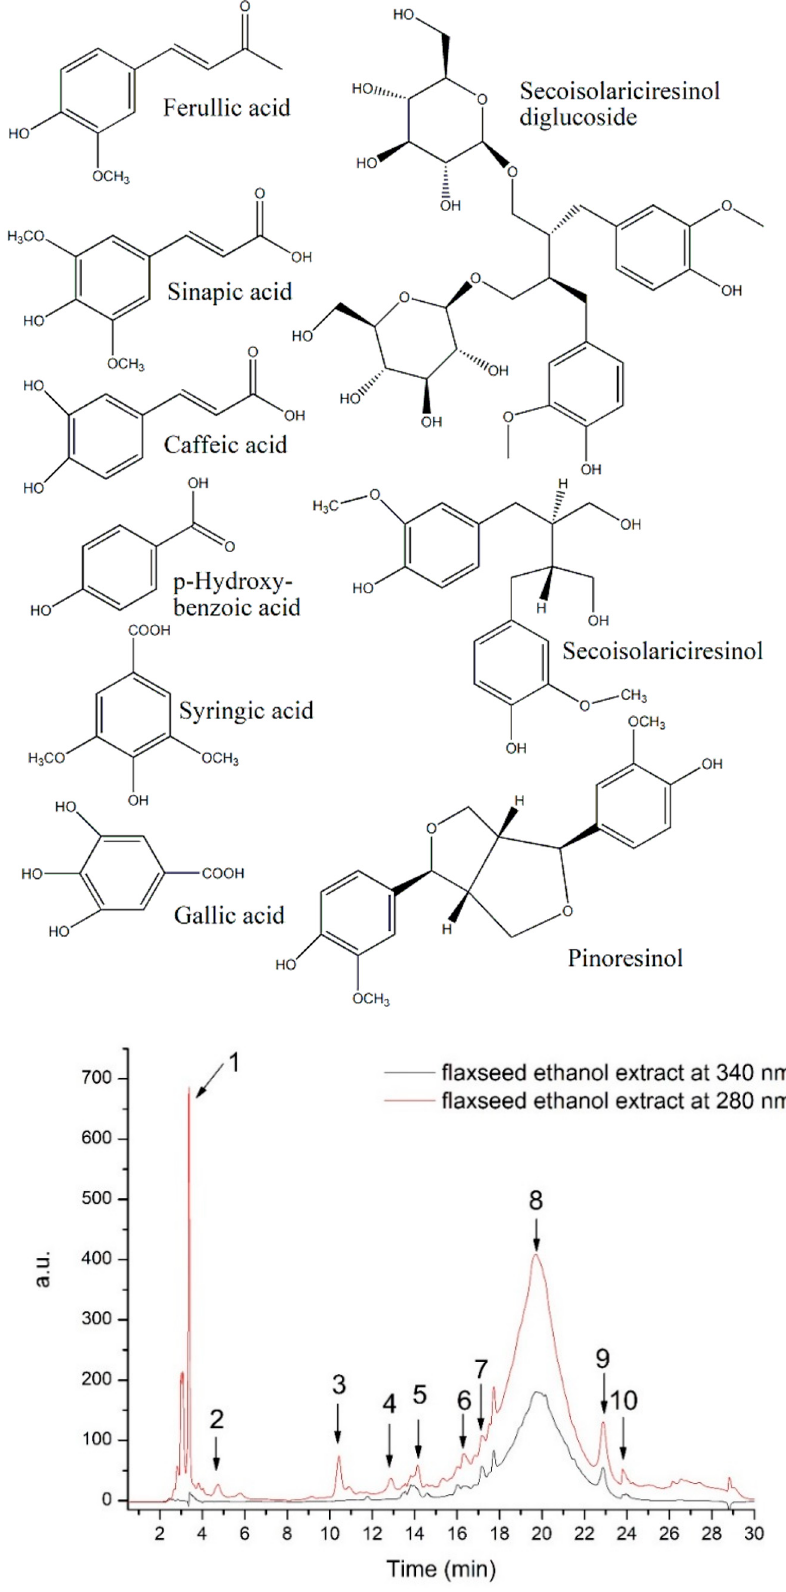
Figure 1. HPLC chromatogram of flaxseed ethanol extract and chemical structure of main identified peaks as listed in Table 1.